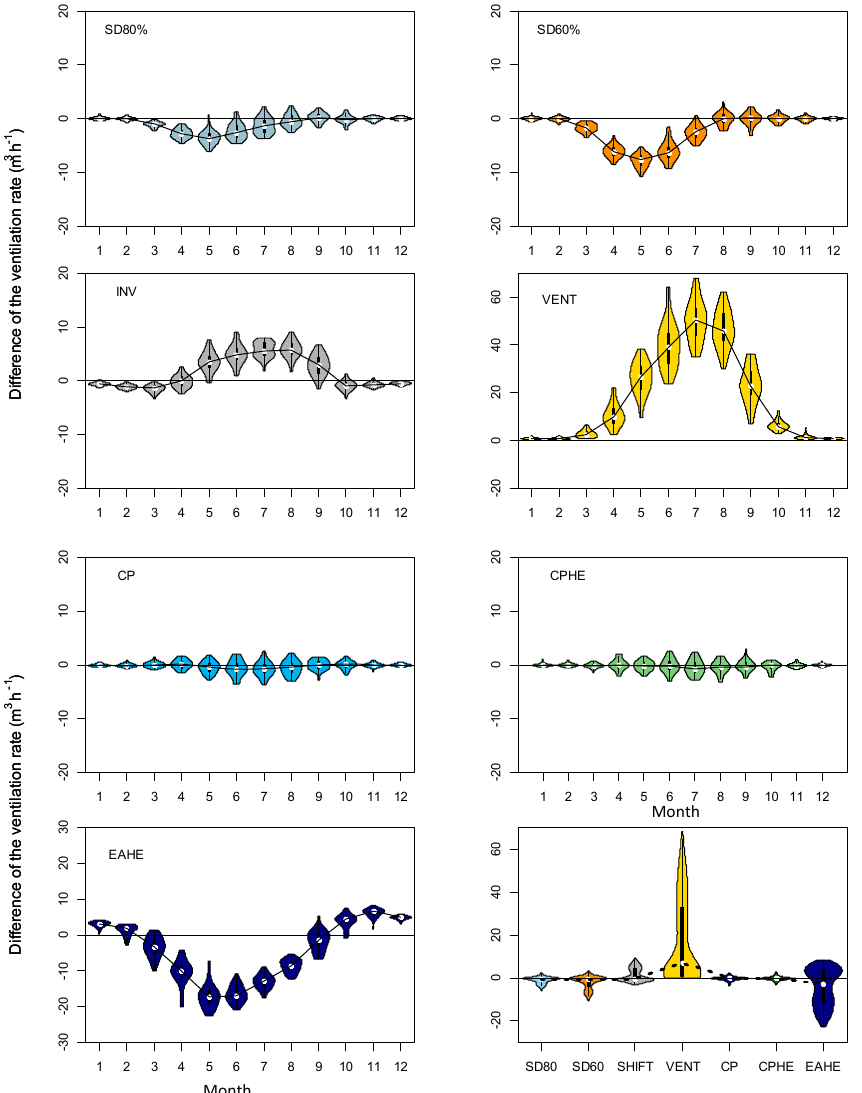
Figure 3. Violin plot of the difference of the ventilation rate per animal place (m³ h − 1 ) of the monthly mean values (period 1981–2017) of a specific AM relative to the reference building REF: stocking density SD80%; stocking density SD60%; inversion of the resting and activity periods INV doubling the ventilation rate VENT; cooling pads (CP); cooling pads and heat exchanger CPHE; and earth-air heat exchanger EAHE. The annual mean values of the ventilation rate difference (black dashed line), as well as their intra-annual spread, are shown in the lowest right graph. Note different y-axis ranges for VENT, EAHE, and the annual mean chart.